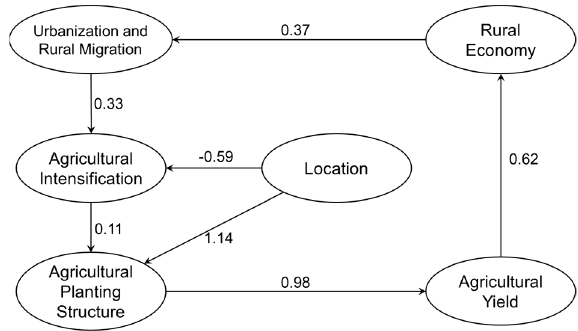
Figure 11. Diagram of the direct effect (Standardized estimates) linkages between the latent variables.